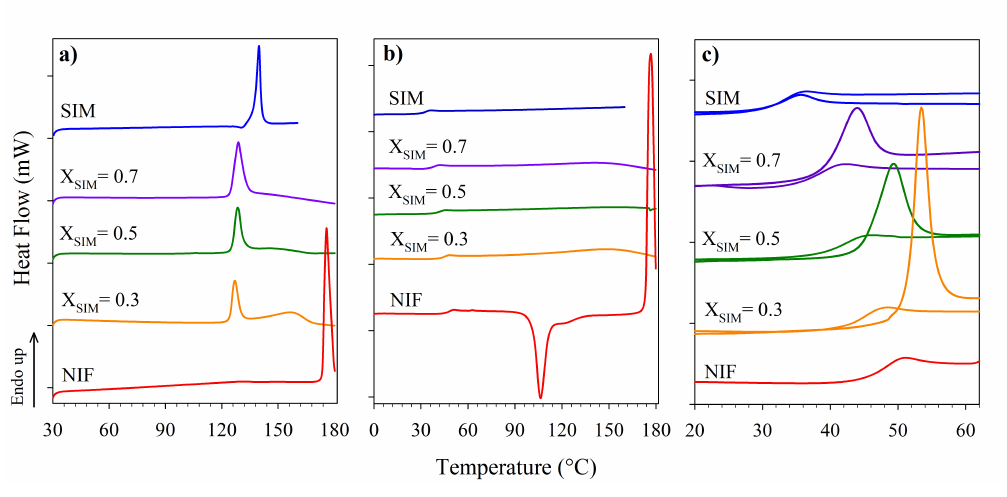
Figure 2. Thermograms for SIM, NIF, and representative binary mixtures ( a ) First heating of samples in crystalline phase. ( b ) Second heating of samples in amorphous form. ( c ) Glass transition temperatures